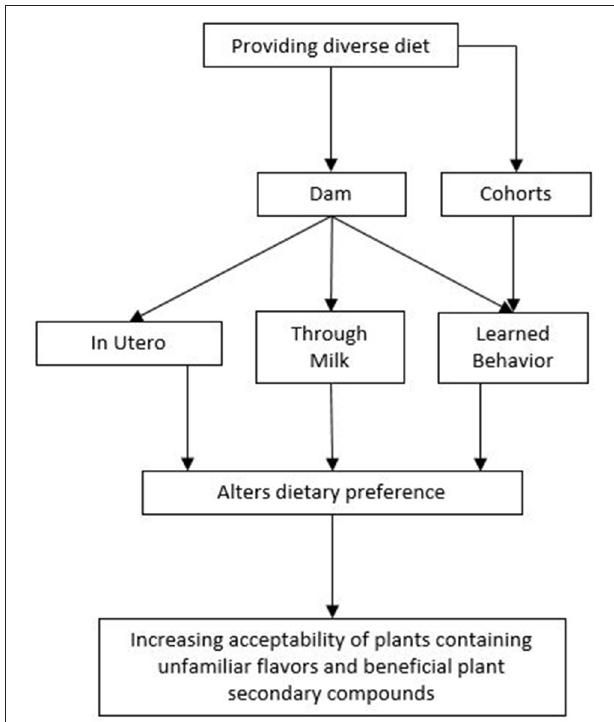
FIGURE 3 | How dietary diversity can program and teach ruminants to alter their dietary preference and increase intake of plants containing beneficial plant secondary